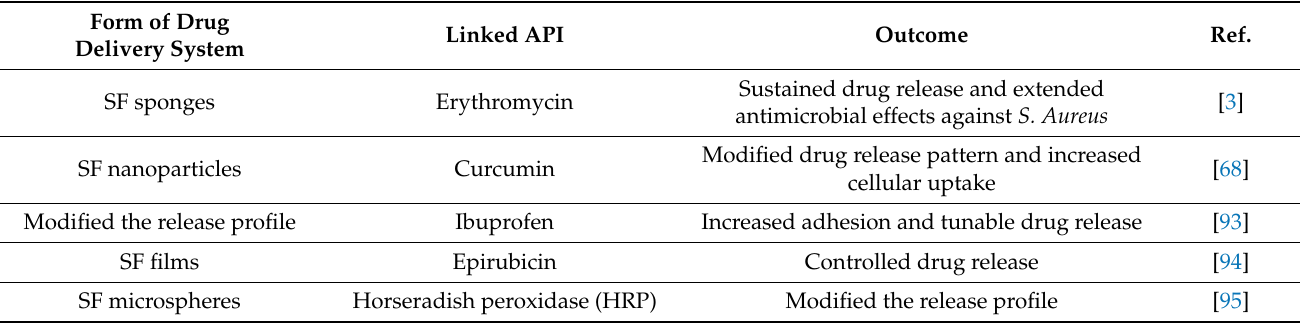
Table 2. SF-based drug delivery systems.